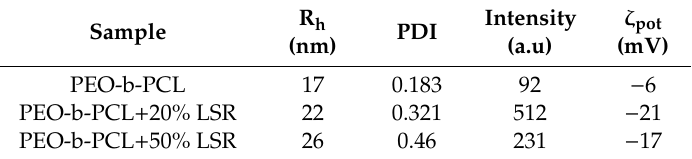
Table 2. Dynamic and electrophoretic light scattering (DLS and ELS) results for the PEO-b-PCL copolymer and LSR-loaded PEO-b-PCL nanocarriers in aqueous solutions. PDI = polydispersity